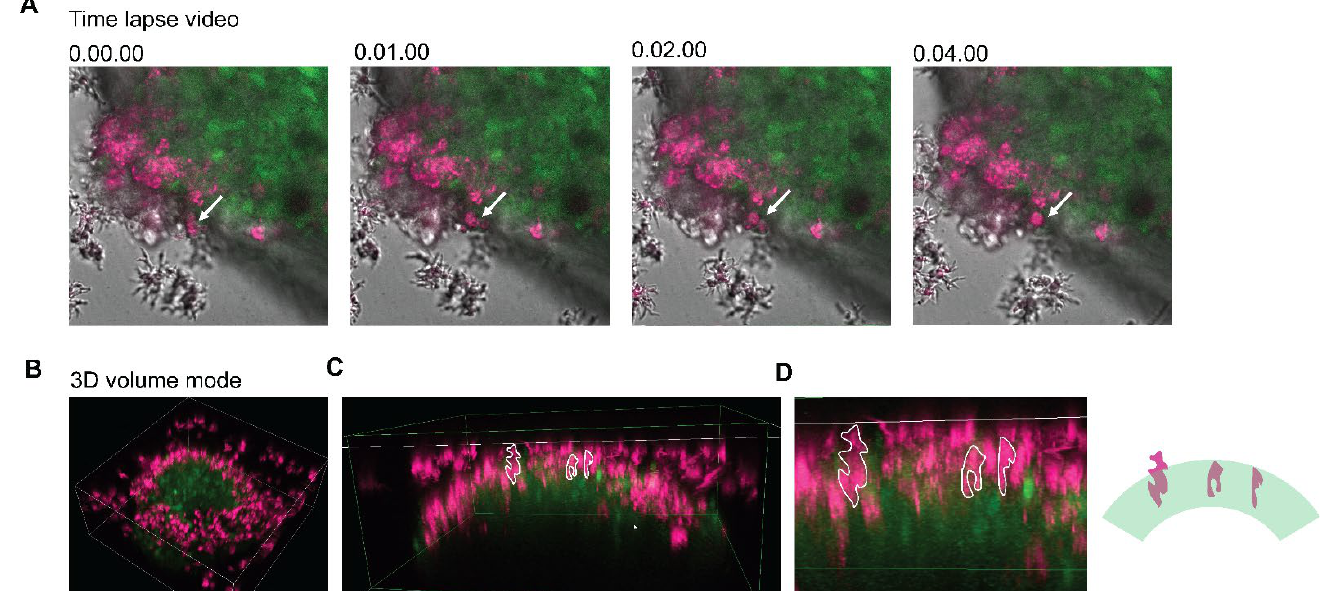
Figure 5. Time-lapse video and 3D view of the neurospheroid cocultured with B. mandrillaris trophozoites. ( A ) Host–parasite interaction recorded using the time-lapse mode of a confocal microscope. B. mandrillaris trophozoites are magenta, while the human neurospheroid is green. ( B ) The 3D view of the neurospheroid (green) surrounded by the B. mandrillaris trophozoites (magenta). ( C ) Cross-section view of the 3D image at the edge of the neurospheroid. Dotted lines are trophozoites (magenta). ( D ) Magnified image of Figure 5C. Trophozoites are marked by a dotted line. In the right panel, the diagram shows the anchoring and penetrating behavior of the B. mandrillaris trophozoites (magenta).